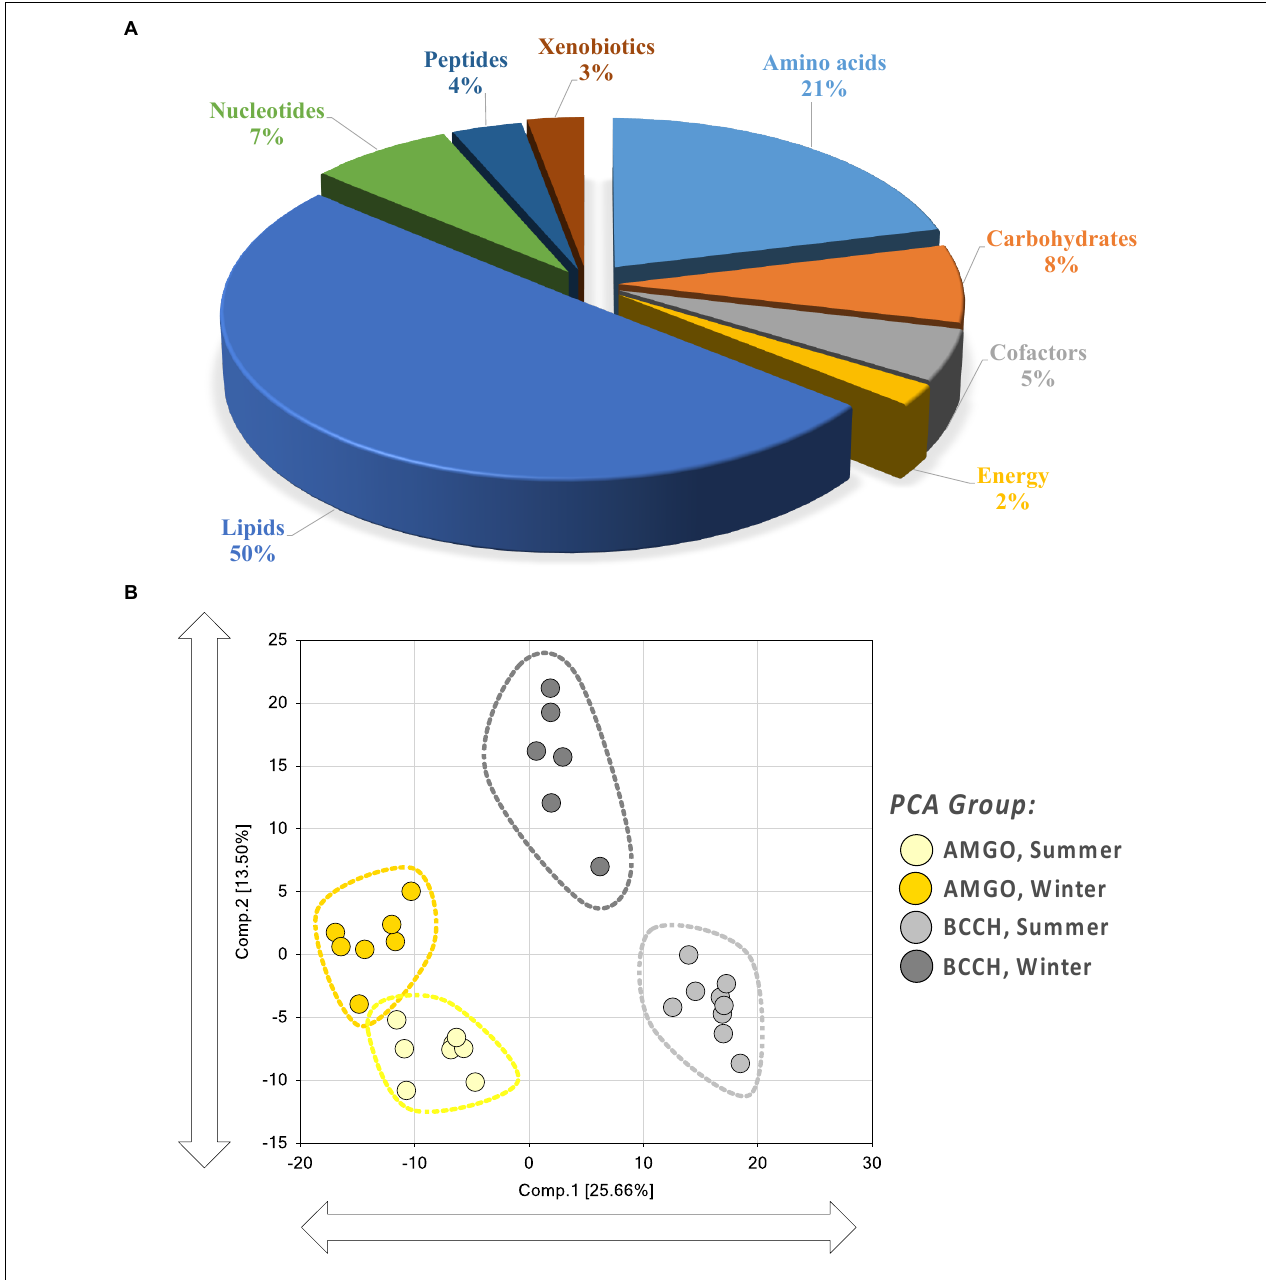
FIGURE 1 | Global metabolome of pectoralis muscle in Black-capped Chickadee (BCCH) and American Goldfinch (AMGO) during Summer and Winter. (A) Functional categorization of 582 identified metabolites detected. (B) Pectoralis muscle sample distribution as determined by Principal Component Analysis (PCA). Ovoids highlight species/season